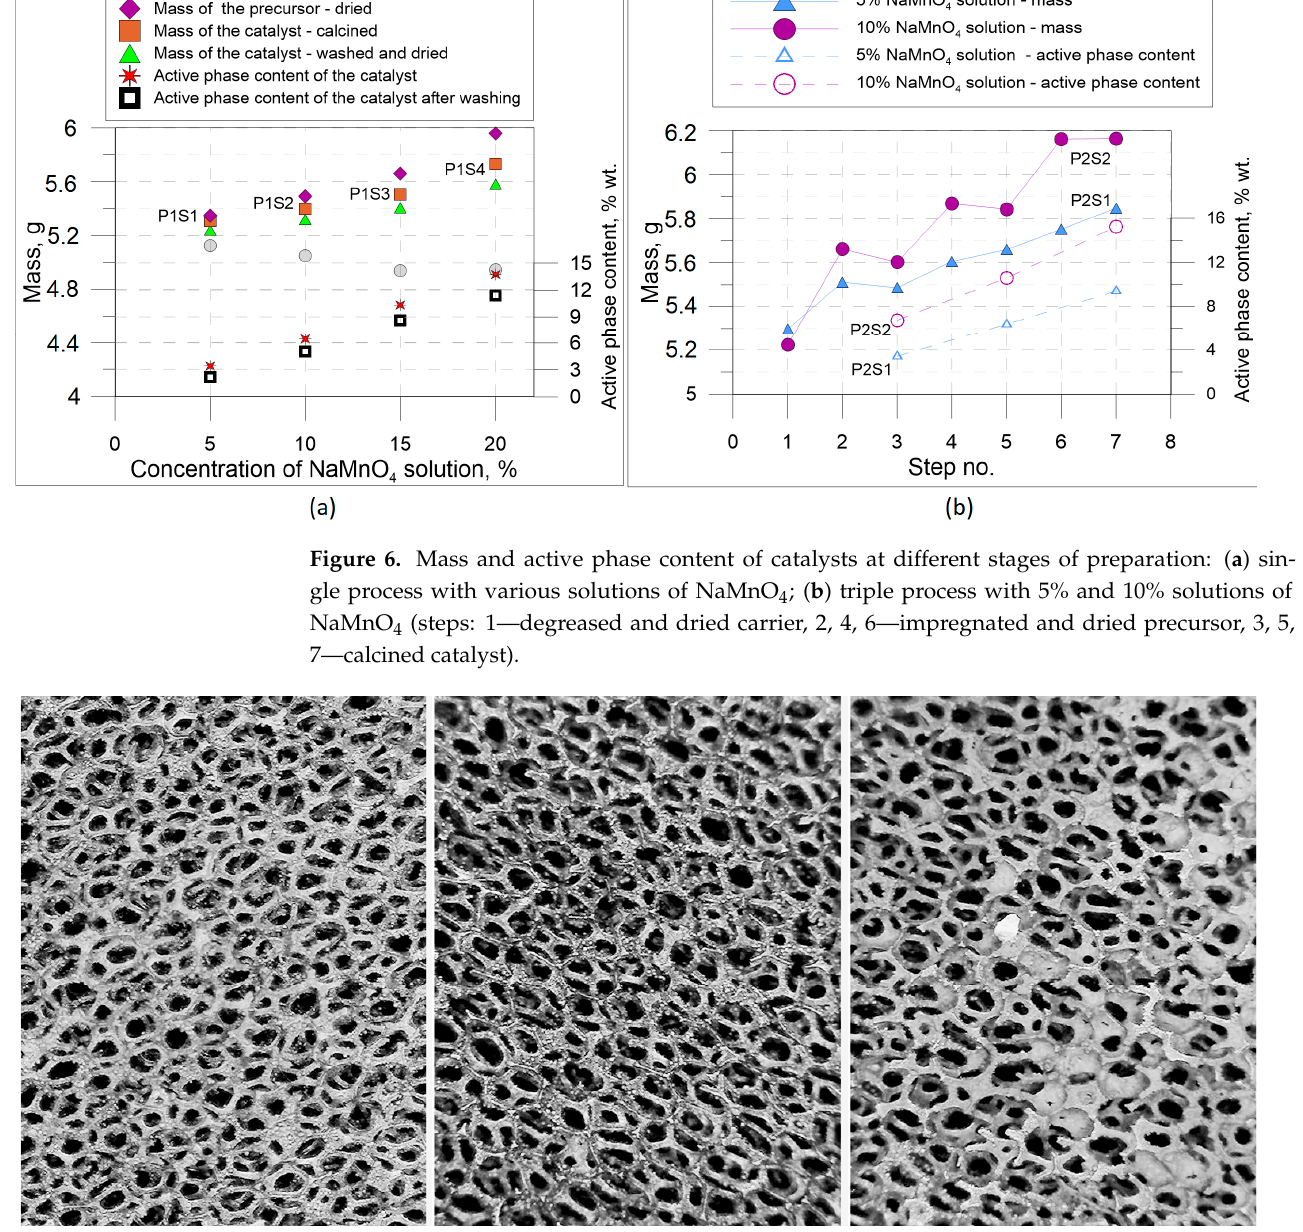
Figure 7. Catalysts photographed under 50 times magnification: ( a ) carrier; ( b ) sample P1S1—5% solution; ( c ) sample P1S4—20% solution.